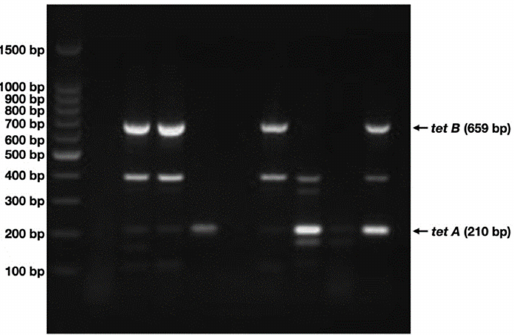
Figure 4. Detection of tetA and tetB by multiplex PCR. Agarose gel electrophoresis of representative negative, tetA and/or tetB positive samples is shown. Amplification fragments for each gene are indicated on the right and molecular weight markers on the left.